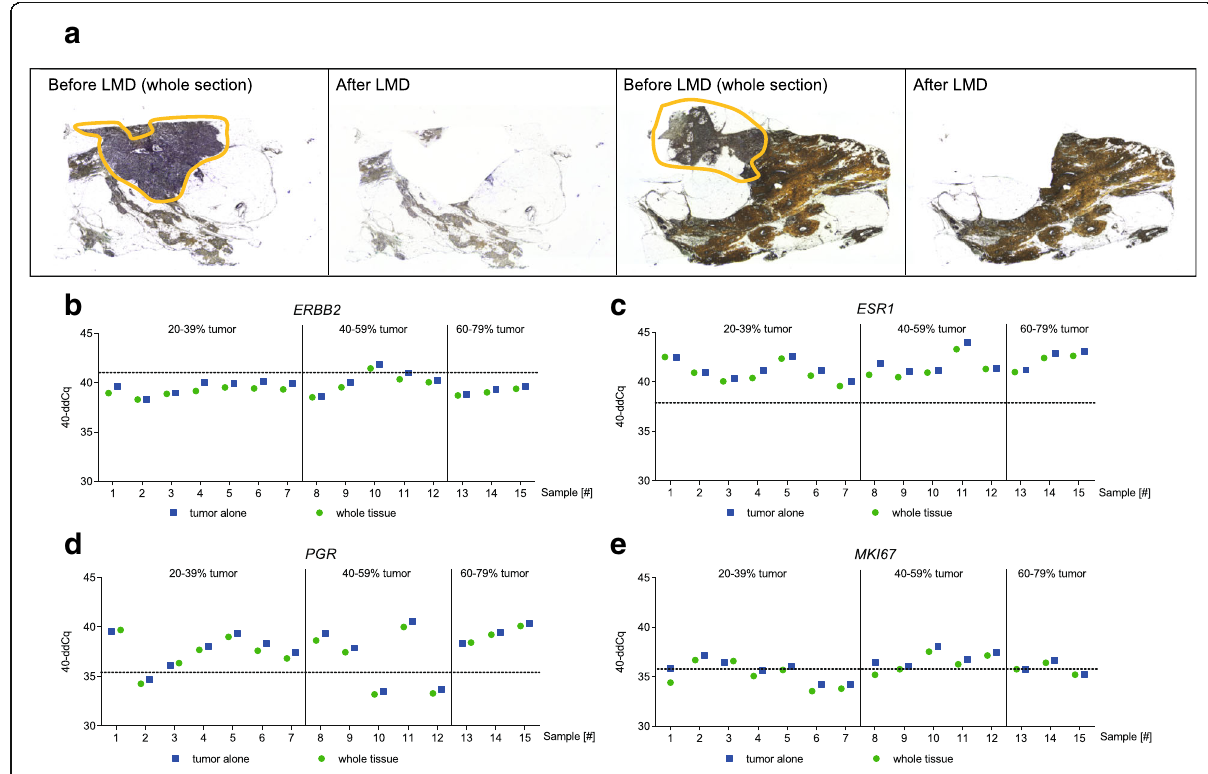
Fig. 3 Effect of normal tissue and TCC on relative gene expression. a Representative images of sample number 9 (left) and sample number 3 (right) before and after microdissection of the respective tumor area (encircled in orange). b - e Shown in the graph are gene expression data of n = 15 breast cancer specimen for ERBB2 ( b ), ESR1 ( c ), PGR ( d ) and MKI67 ( e ) in whole sections (green circles) versus tumor-enriched sections (blue squares). Dotted lines represent the respective cut-off for the four marker genes ( ERBB2 : 41.10; ESR1 : 38.00; PGR : 35.50; MKI67 :